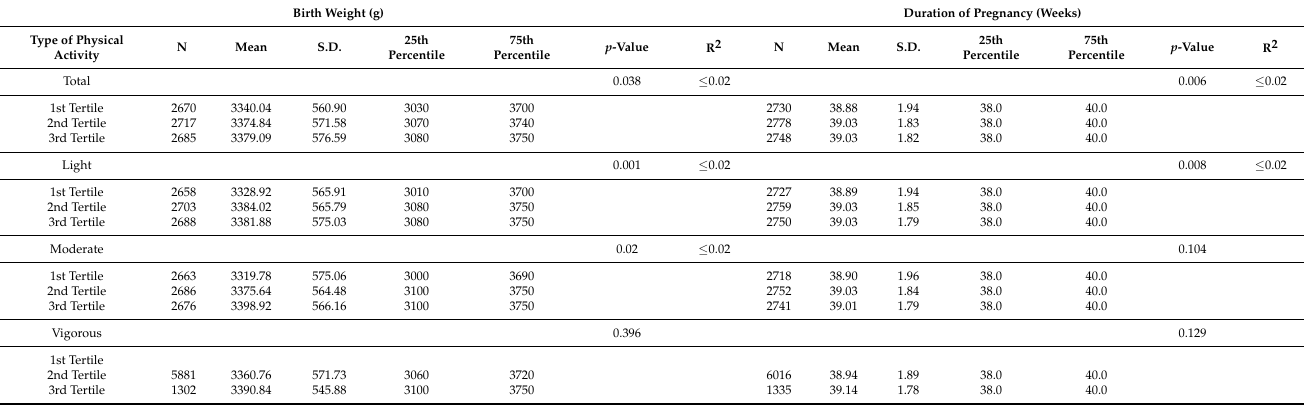
Table 3. Impact of physical activity on infant birth weight and the duration of